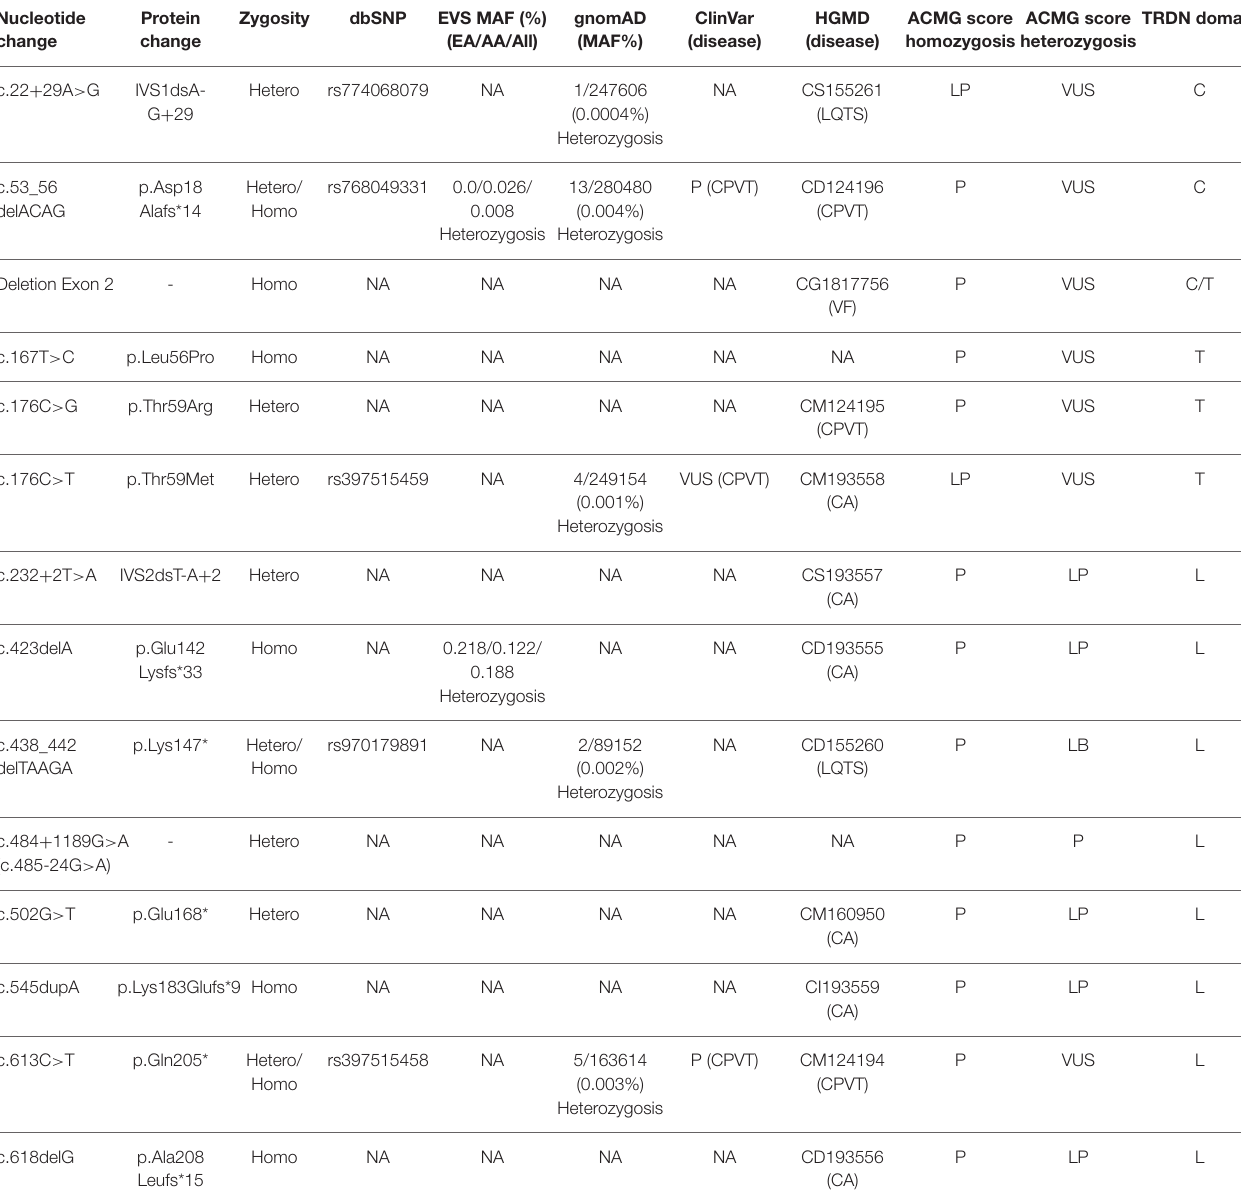
TABLE 1 | Genetic data of rare variants in TRDN . Nucleotide Protein change